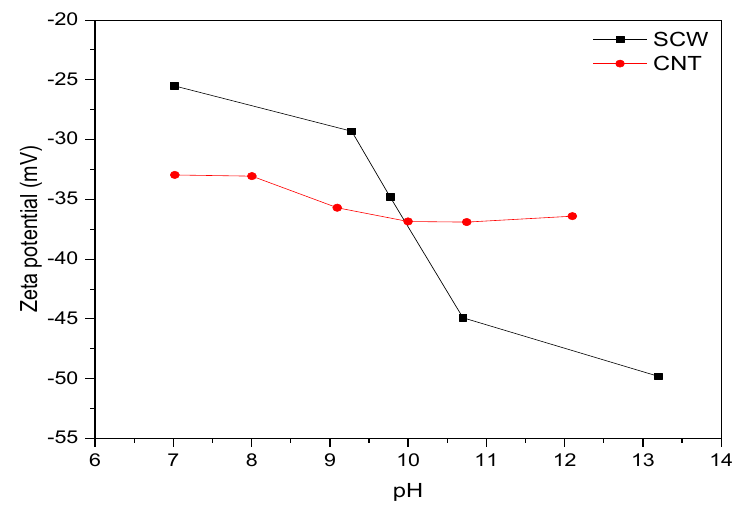
Figure 7. Zeta potential of SCW and CNT aqueous dispersions at different pH values.